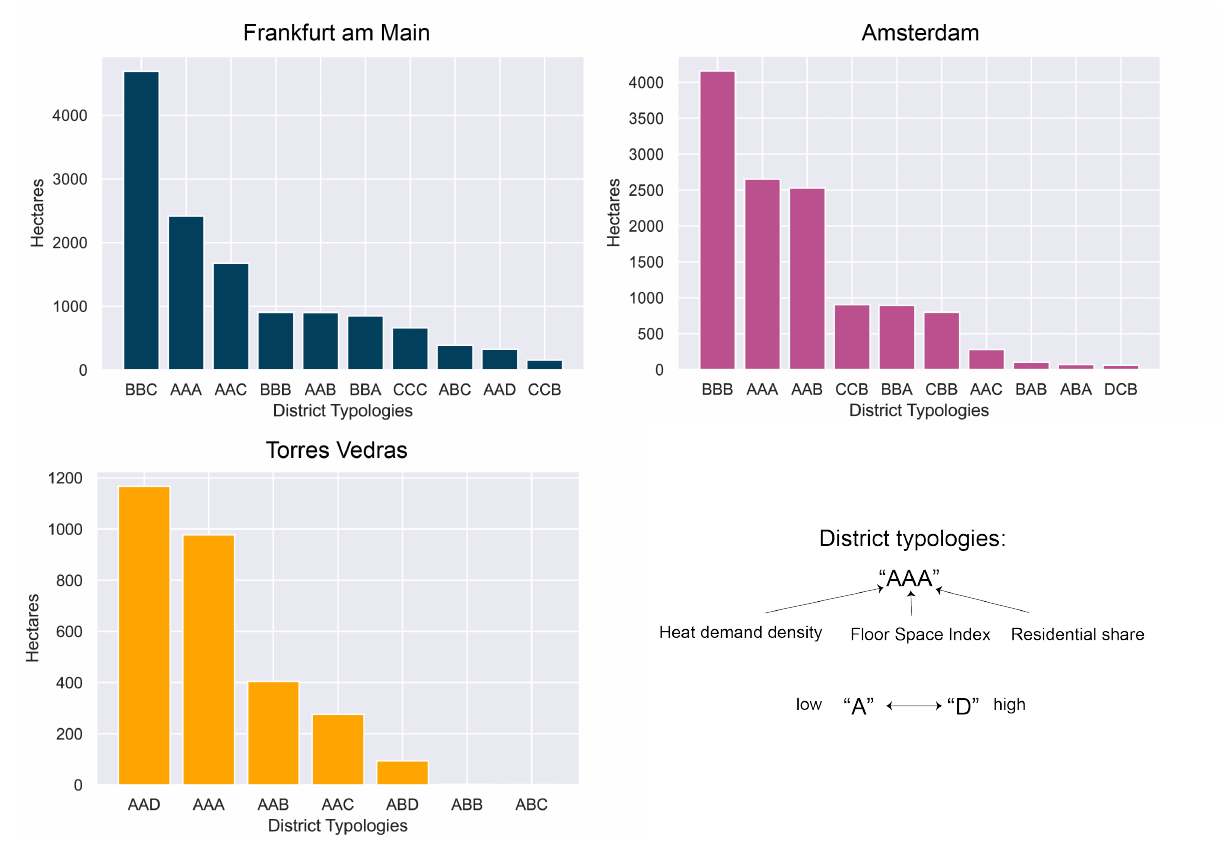
Figure 8. A comparison of the frequency of the district categories in Frankfurt am Main, Amsterdam and Torres Vedras.